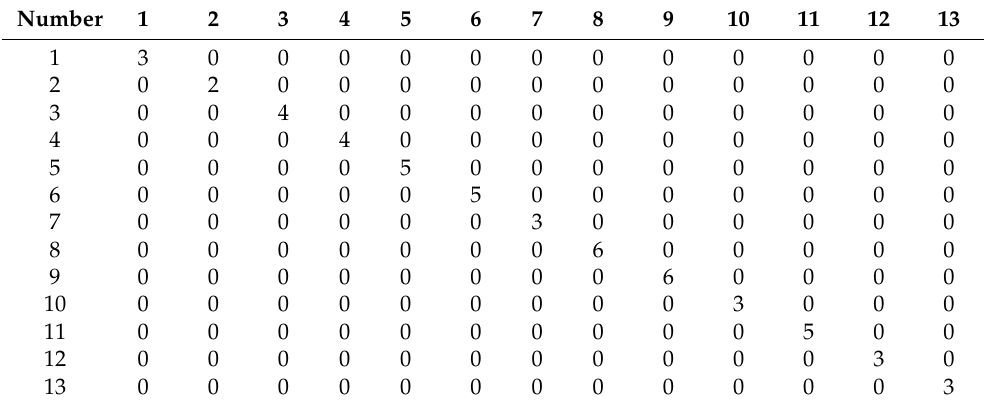
Table 5. Degree matrix of the cities in Jiangsu Province.